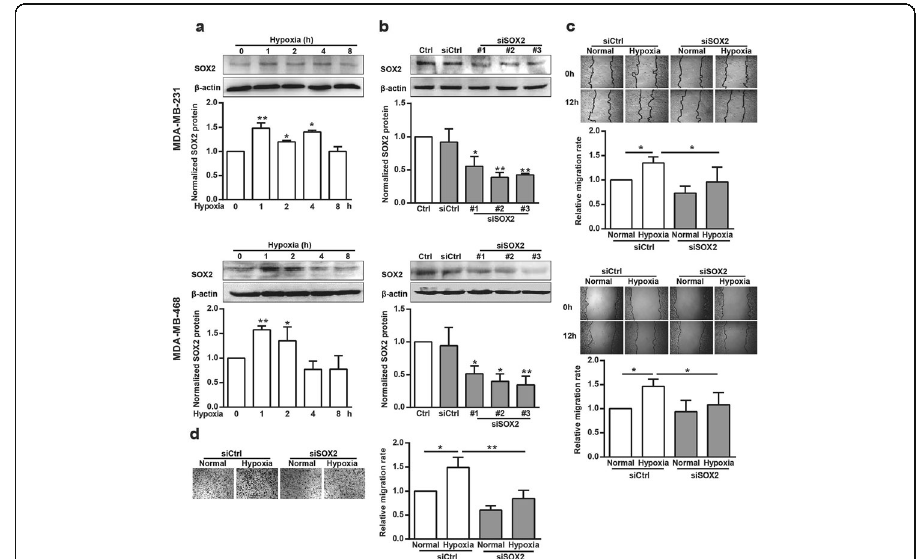
Fig. 1 The effect of SOX2 on hypoxia-induced breast cancer cell migration. ( a ) MDA-MB-231 and MDA-MB- 468 cells were incubated under hypoxia for the indicated times. Cellular lysates were assayed for SOX2 expression using western blotting. SOX2 was quantified and normalized against β -actin. * p < 0.05, ** p < 0.01, referring to the difference between cells incubated with or without hypoxia. ( b ) Cells were transfected with siCtrl or siSOX2 for 48 h, then total protein extracts from cells transfected with siSOX2 were analyzed via western blotting for SOX2. SOX2 was quantified and normalized against β -actin. * p < 0.05, ** p < 0.01, referring to the difference between cells treated with siCtrl or siSOX2. ( c ) The migratory capacity of cells transfected with siSOX2 under hypoxia for 12 h was evaluated using a wound-healing assay. ( n = 10) * p < 0.05. ( d ) The migratory capacity of MDA-MB-231 cells transfected with siSOX2 under hypoxia for 12 h was evaluated using a transwell assay. * p < 0.05, ** p <